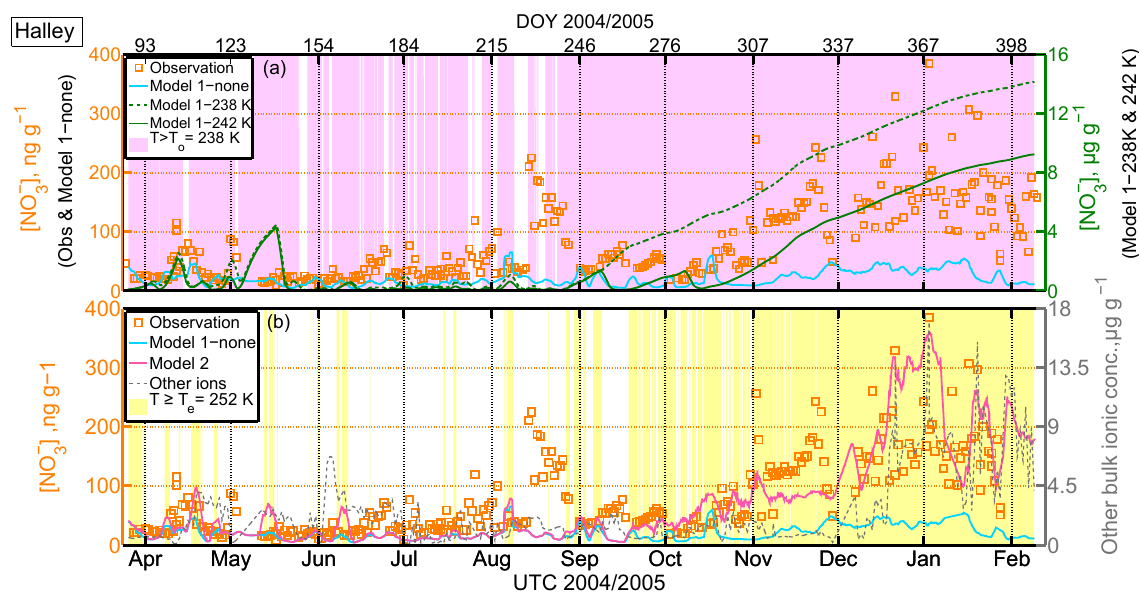
Figure 7. (a) Model 1 output of Halley skin layer snow concentration of NO − . At T <T o the interface between air and snow grain is 3 assumed to be ice (air–ice) and the NO − concentration is determined by a combination of non-equilibrium adsorption on ice and co- 3 condensation coupled with solid-state diffusion. At T >T o , the interface between air and snow grain is assumed to be a DI (air–DI); i.e. the NO − concentration is determined by a combination of non-equilibrium solvation into the DI coupled with solid-state diffusion. Orange 3 squares: observation; light blue: Model 1 with T o >T m , i.e. only air–ice interaction; dark blue: Model 1 with T o = 238K; green: Model 1 with T o = 242K; the purple shaded area indicates times when T >T o = 238K; (b) Model 2 output of Dome C skin layer snow NO − 3 concentration. The major interface between air and snow is assumed to be ice (air–ice) at T <T m and the NO − concentration in ice is 3 determined by a combination of non-equilibrium adsorption and co-condensation coupled with solid-state diffusion. Above T >T e = 252K, liquid coexists with ice in the form of a micropocket. The partition between air and micropocket is determined by Henry’s law. Orange squares: observation; light blue: Model 1 with T o >T m , i.e. air–ice-only interaction; Pink: Model 2 – air–ice interaction plus micro-liquid pockets; grey (right axis) – measured bulk concentration of other ions, where other ions refers to the sum of [Na + ] and [Cl − ]; the yellow shaded area indicates times when T >T e = 252K ( T e for NaCl–H 2 O